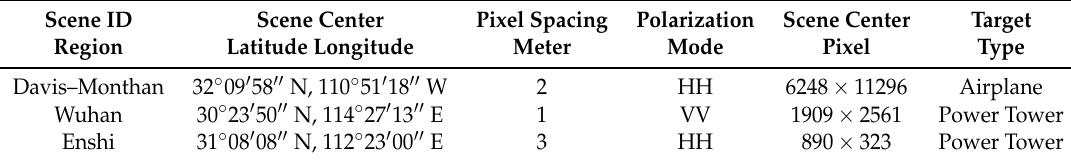
Table 2. List of TerraSAR-X SAR imagery used for target